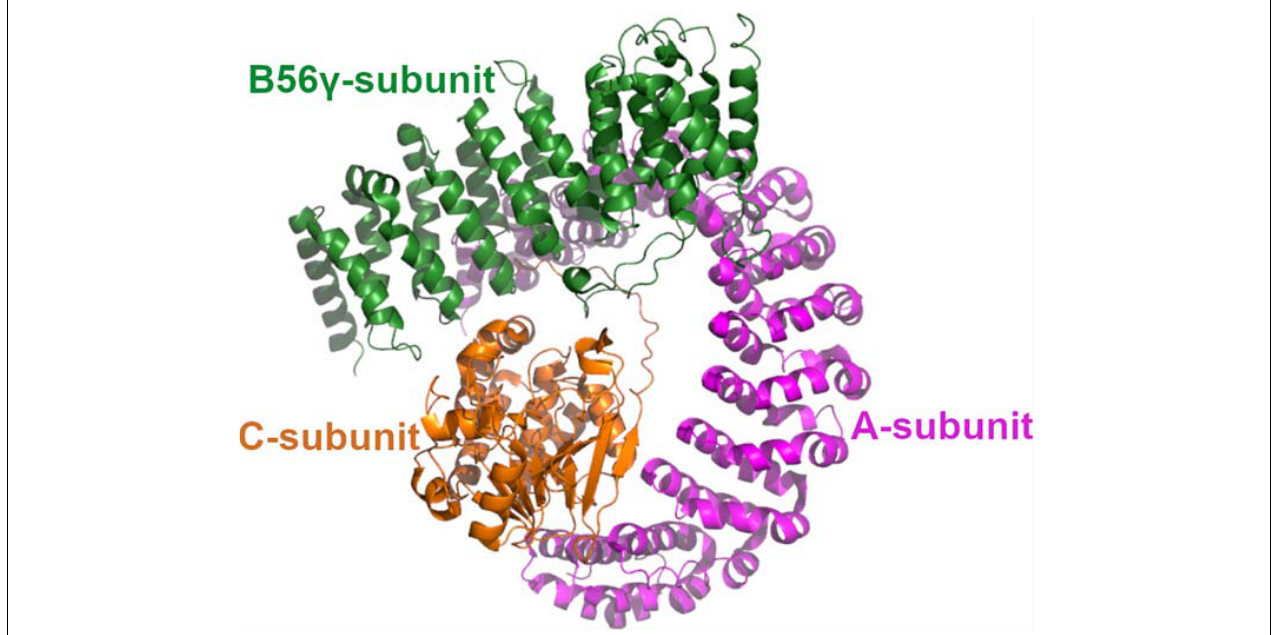
FIGURE 1 | The structure of PP2A. The 3D structure of PP2A. The scaffolding A-subunit (PR65 α ) is shown with magenta, regulatory B56 γ subunit shown with green and the catalytic C α -subunit with orange. The coordinates are taken from